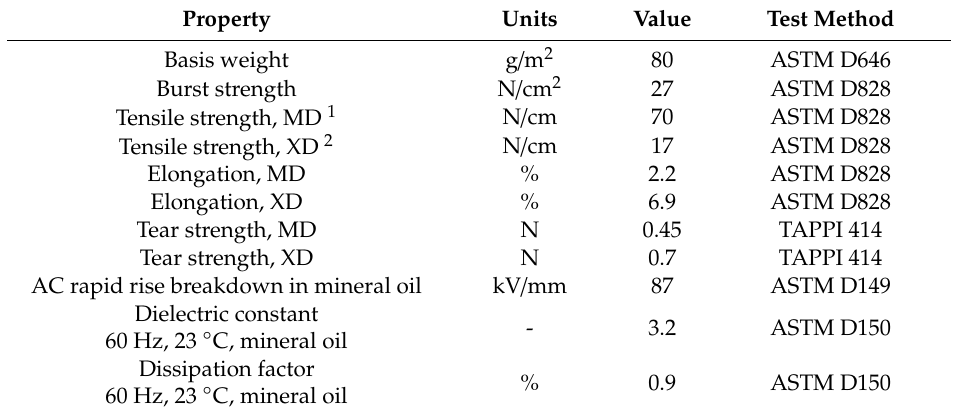
Table 1. Typical mechanical and electrical properties of NOMEX ® 910 paper (thickness 0.08 mm). Data from o ffi cial DuPont ™ online data sheet available online [16].